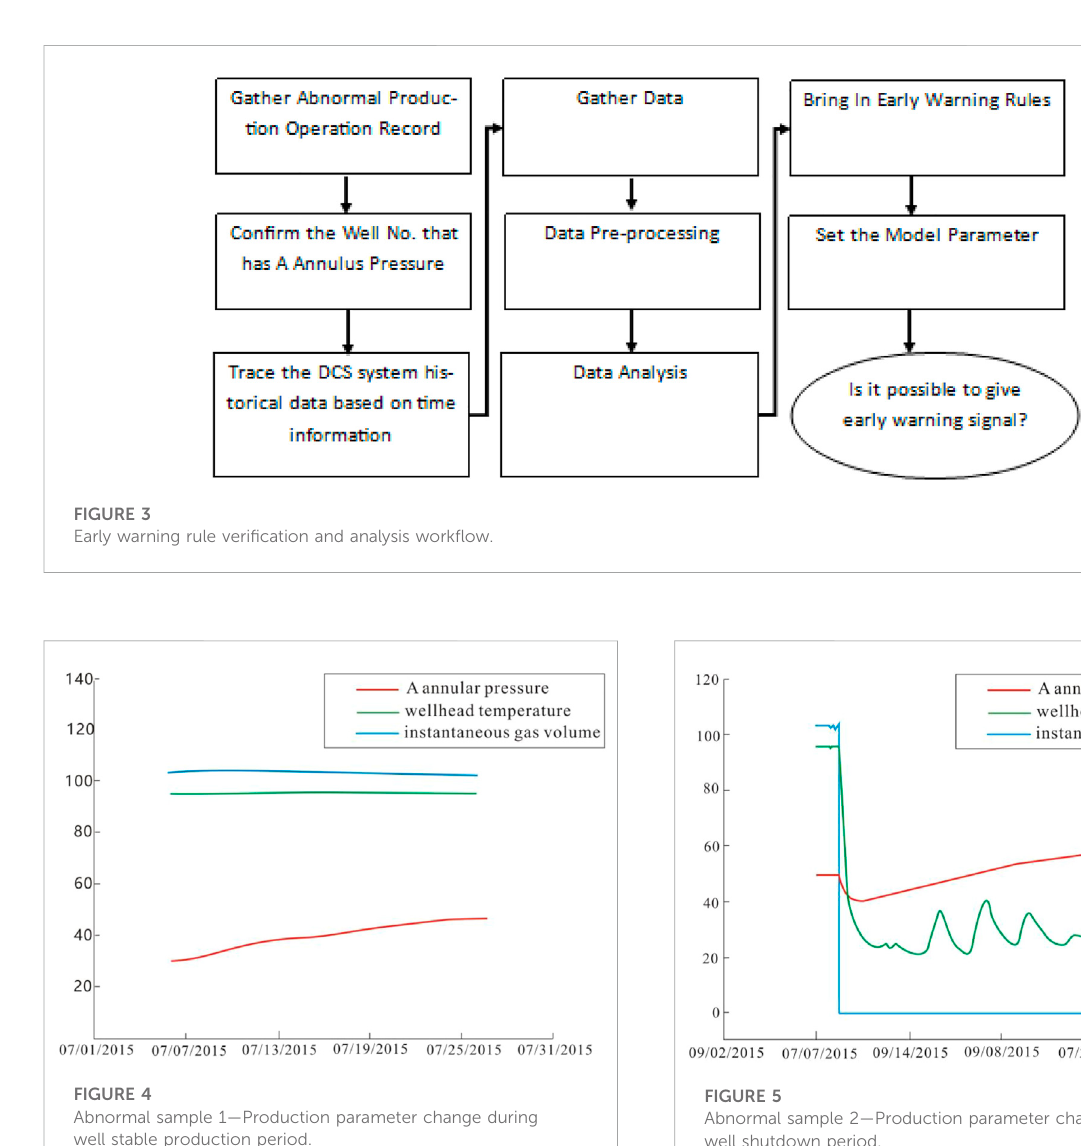
FIGURE 4 Abnormal sample 1 — Production parameter change during well stable production period.